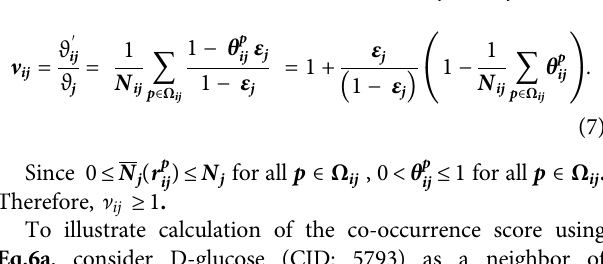
Frontiers in Research Metrics and Analytics |